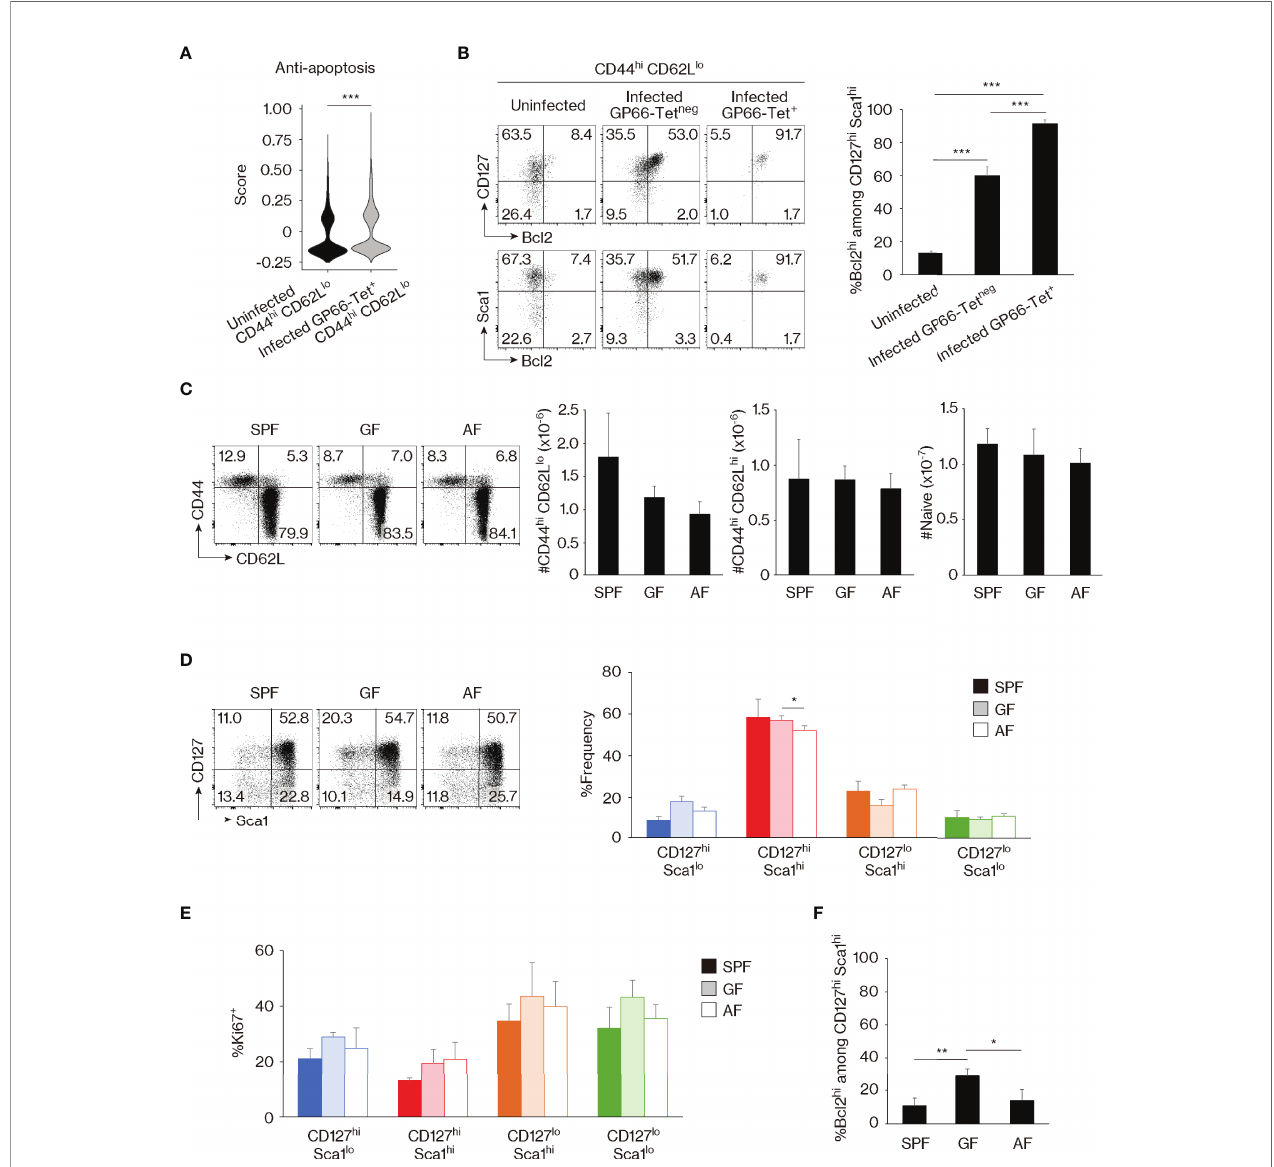
FIGURE 2 | Bcl2 marks foreign antigen (Ag)-speci fi c memory versus self-driven memory-phenotype (MP) cells. (A) Comparison of gene expression between MP versus foreign Ag-speci fi c memory cells. The violin plot shows relative expression of anti-apoptotic genes across populations. The anti-apoptotic gene list is provided in Materials and Methods and Table S1 . (B) Foreign Ag-speci fi c memory cells are Bcl2 hi . The representative dot plots display expression levels of CD127, Sca1, and Bcl2 in the indicated CD44 hi CD62L lo cell populations, while the bar graph shows the frequency (mean ± SD) of Bcl2 hi cells among the indicated CD127 hi Sca1 hi subpopulations (n = 3 – 4 mice). Data are representative of 2 independent experiments. (C, D) Commensal or food Ags do not signi fi cantly contribute to generation of CD127 hi Sca1 hi MP cells in speci fi c pathogen-free (SPF) environment. Dot plots depicting expression of (C) CD44 and CD62L in CD4 + T lymphocytes as well as (D) CD127 and Sca1 in MP cells from the indicated animals together with bar graphs indicating (C) the number (mean ± SD) of CD44 hi CD62L lo (MP), CD44 hi CD62L hi , and CD44 lo CD62L hi (naïve) CD4 + T cells as well as (D) the frequency (mean ± SD) of MP subpopulations among total MP cells from each group are displayed (n = 3 – 4 mice). Data are representative of 2 independent experiments performed. (E, F) Expression levels of Ki67 and Bcl2 in MP cells are largely unaltered in the absence of commensal and/or food Ags. (E) The bar graph shows the frequency (mean ± SD) of Ki67 + cells among the indicated MP subpopulations (n = 3 – 4 mice). (F) A bar graph indicating the frequency (mean ± SD) of Bcl2 hi cells among CD127 hi Sca1 hi MP cells from the indicated groups (n = 3 – 4 mice). Data are representative of 2 independent experiments. Statistically signi fi cant differences are indicated as * p < 0.05, ** p < 0.01, and *** p <